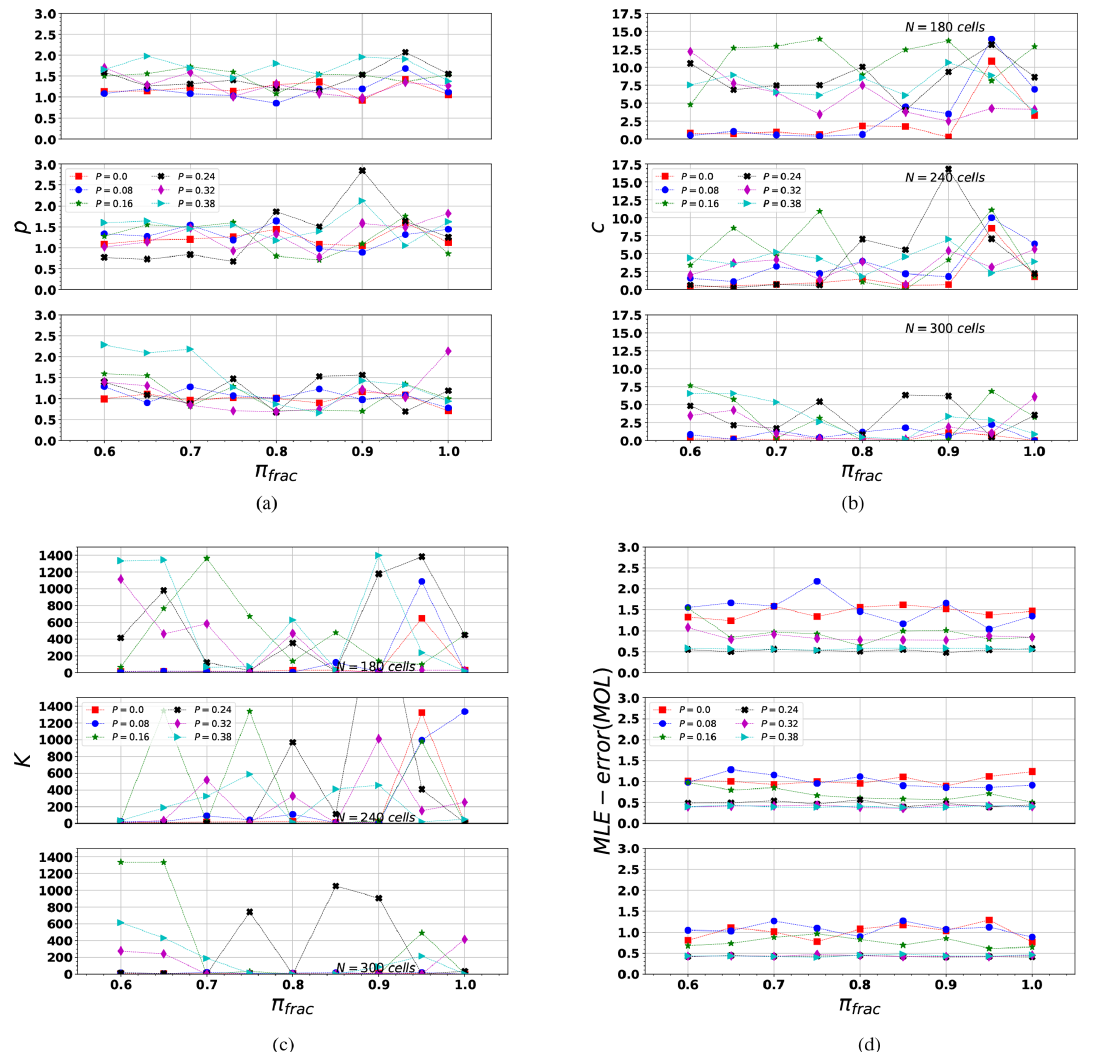
Figure 12. Modified Omori parameters computed in the LA synthetic series: (a) p , (b) c , (c) K , and (d) rms. Each marker is obtained by different synthetic series considering three input parameters ( N , P , π frac ). From top to bottom, N = 180, N = 240, and N = 300 (cells per lateral size in the